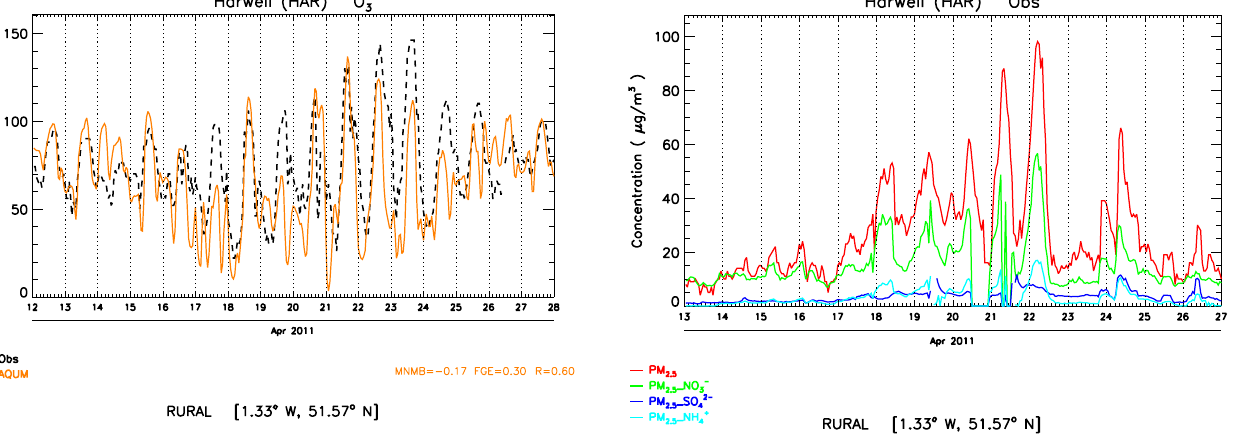
Fig. 12. Speciated PM 2 . 5 measurements at the rural site Harwell for the peak of the April 2011